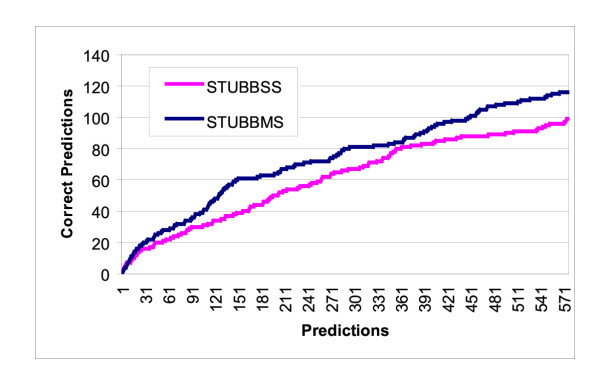
Effect of two-species data on performance, using a more complete data set that includes genes with ubiquitous, maternal-only, or no expression. The axes are as in Figure 1a. (The x-axis has a greater range than in Figure 1a.)